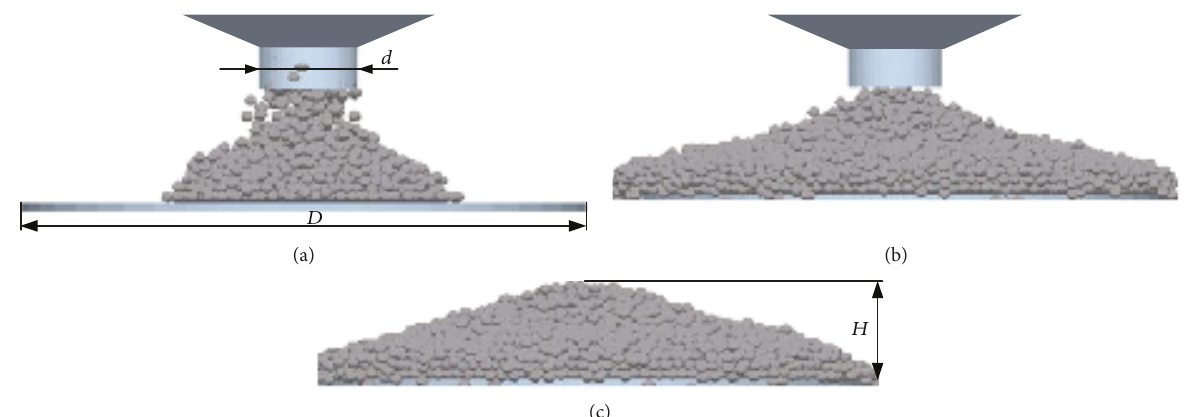
Figure 3: Formation of particulate pile in our DEM simulations: (a) beginning of the particle accumulation, (b) accumulation saturated, and (c) packed particulate pile.